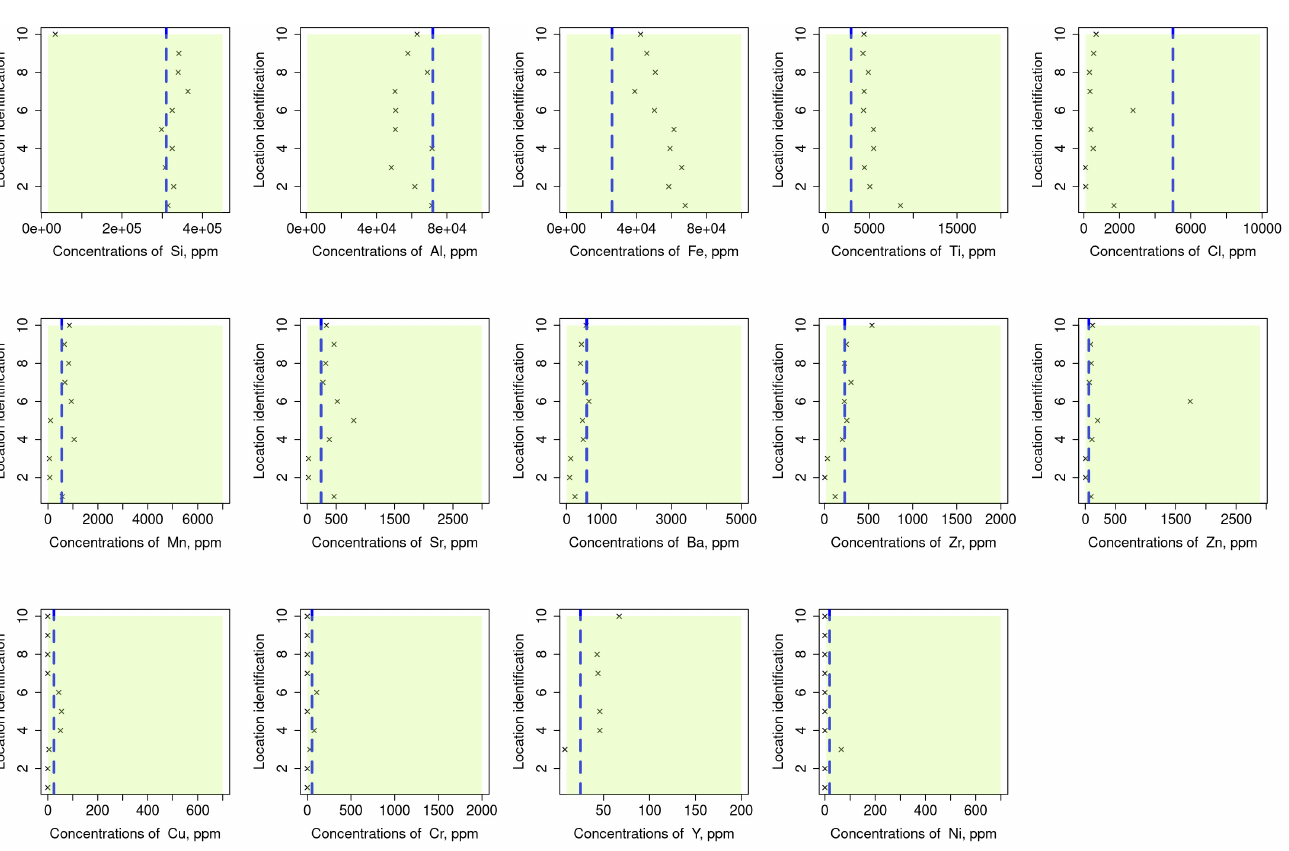
Figure 7. Comparison of the measurements in the studied area to assess the validity of our readings concerning reference values that have been recorded in previous reports, e.g., [54,55]. Green area indicates the range of values, and the blue columns signify the average values of the considered element’s datasets. Some values are shown to fall near the average (e.g., Si, Ba, and Ni) whereas the others fall on the boundaries (e.g., Cl, Cr, and Cu).